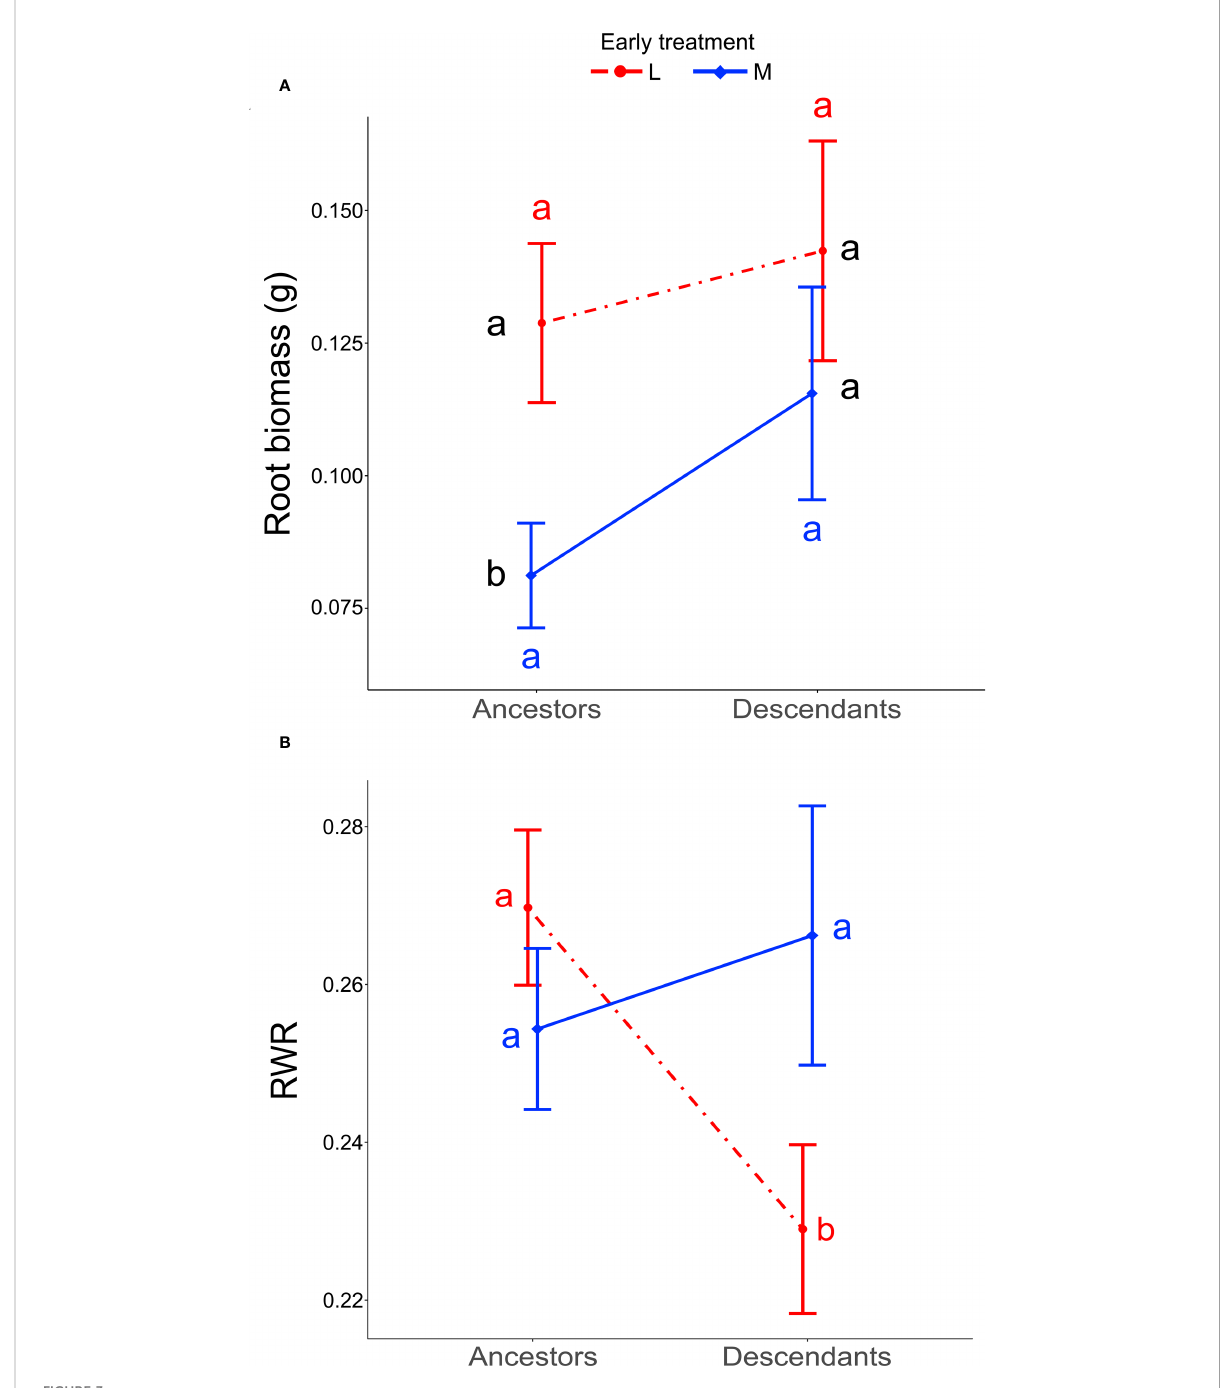
FIGURE 3 Differences between ancestors and descendants in root biomass and RWR. Shown are means ± SE of the two signi fi cant two-way interactions: Early treatment × Generation (ancestors versus descendants) on root biomass (A) and RWR (B) . Black letters represent post-hoc contrasts between both treatments within ancestors or within descendants. Red and blue letters represent post-hoc contrasts between ancestors and descendants in the less and in the more predictable treatment,